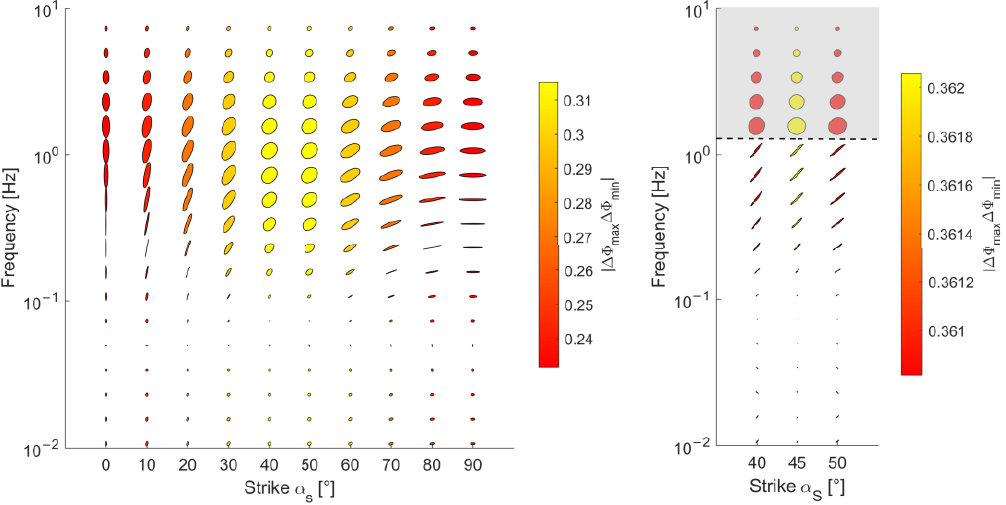
Figure 10. The residual phase tensor for different strike angles of the conductivity x-axis.